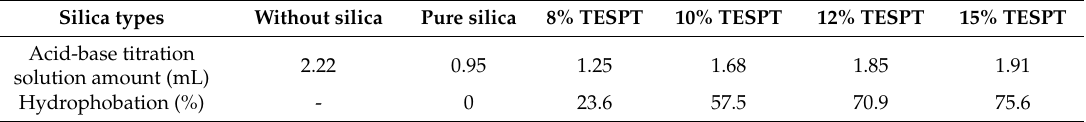
Table 4. Degree of hydrophobation of the modified silica according to the content of TESPT.